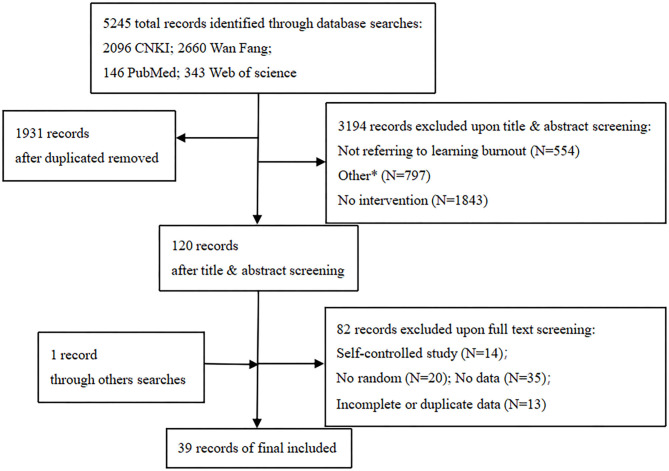
Flow Chart of Study Selection. Flow chart shows literature search for relevant studies about interventions on learning burnout. *Studies were excluded because they were either news reports, commentaries, editorials or a review, protocol.